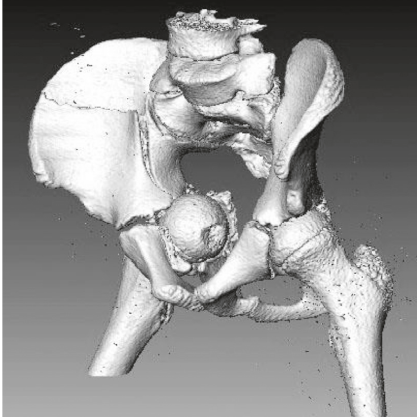
Figure 2: 3D reconstruction showing the medial dislocation with entrapment of the femoral head.